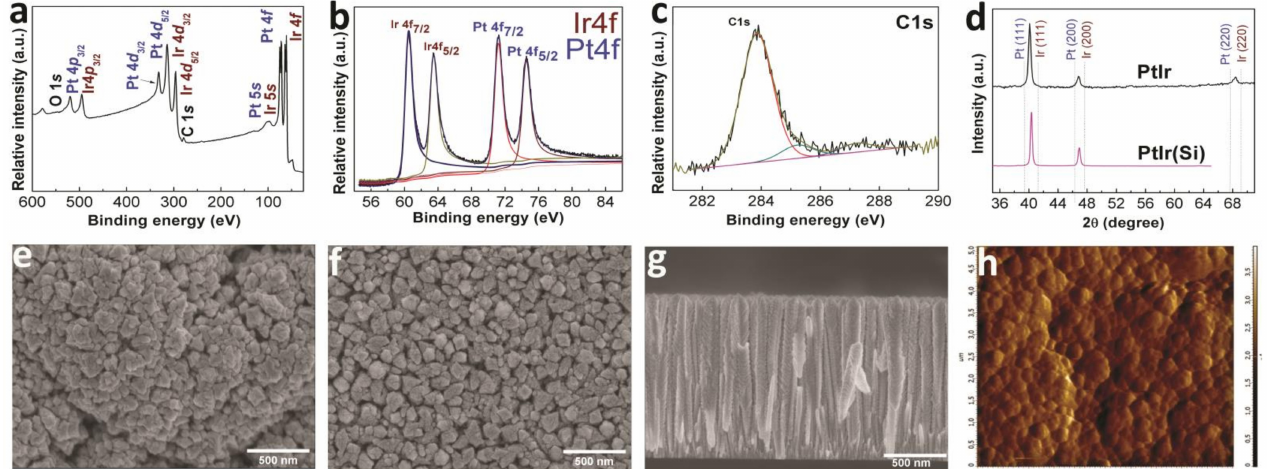
Figure 3. XPS spectra of PtIr(Si) sample after etching with Ar + ( a ), fitting of Pt 4 f and Ir 4 f spectra ( b ), and fitting of C1 s spectra ( c ); XRD patterns of PtIr and PtIr(Si) samples ( d ); SEM micrographs of the sample surface (PtIr ( e ) and PtIr(Si) ( f )) and cross-section of PtIr(Si) sample ( g ); AFM micrograph PtIr(Si) sample ( h ).